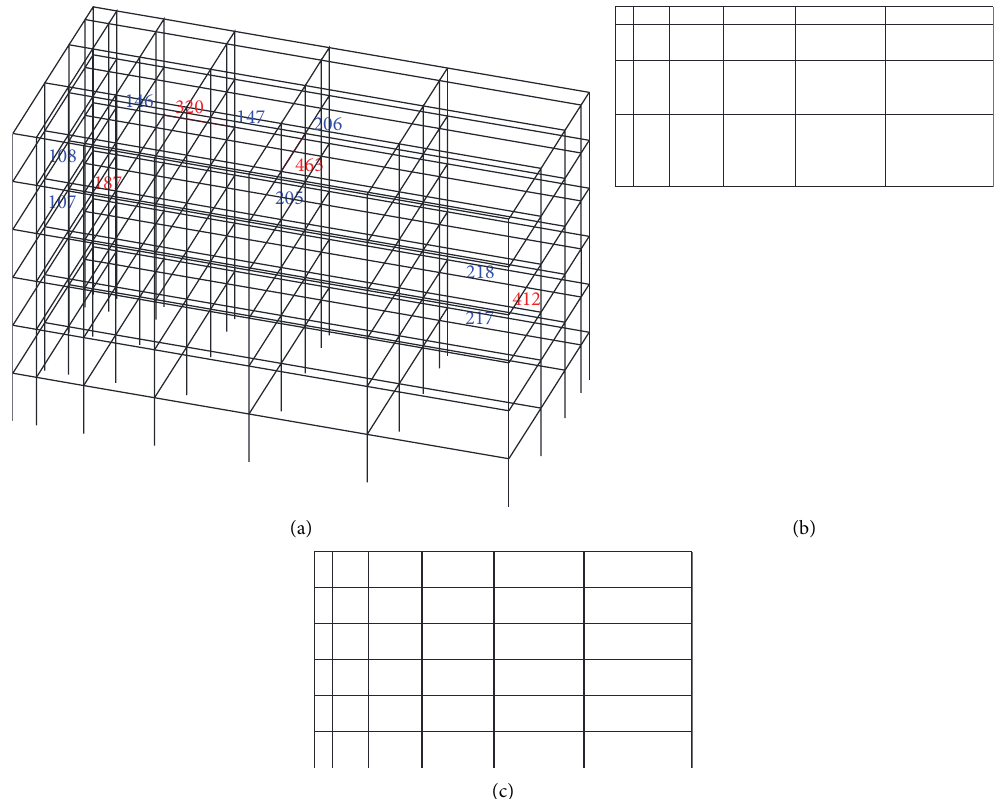
Figure 5: The general modeling scheme and induced damage members of building with the unsymmetrical distribution of columns. (a) 3D view. (b) Plan view. (c) Elevation